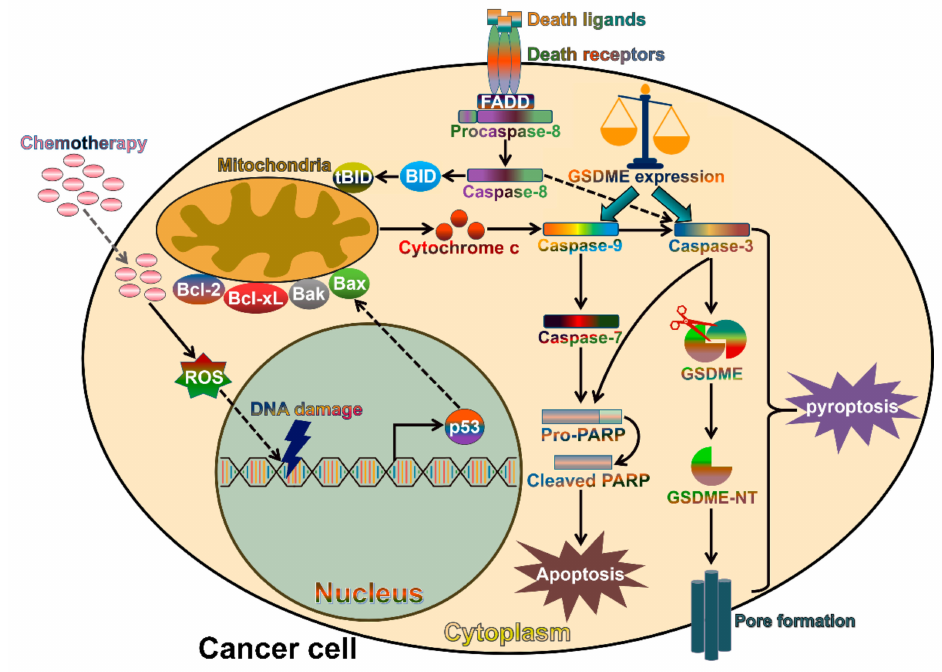
Figure 3. Schematic representation of chemotherapy-induced apoptosis and pyroptosis in cancer cell. Apoptosis is induced via the intrinsic or extrinsic death signaling pathway.